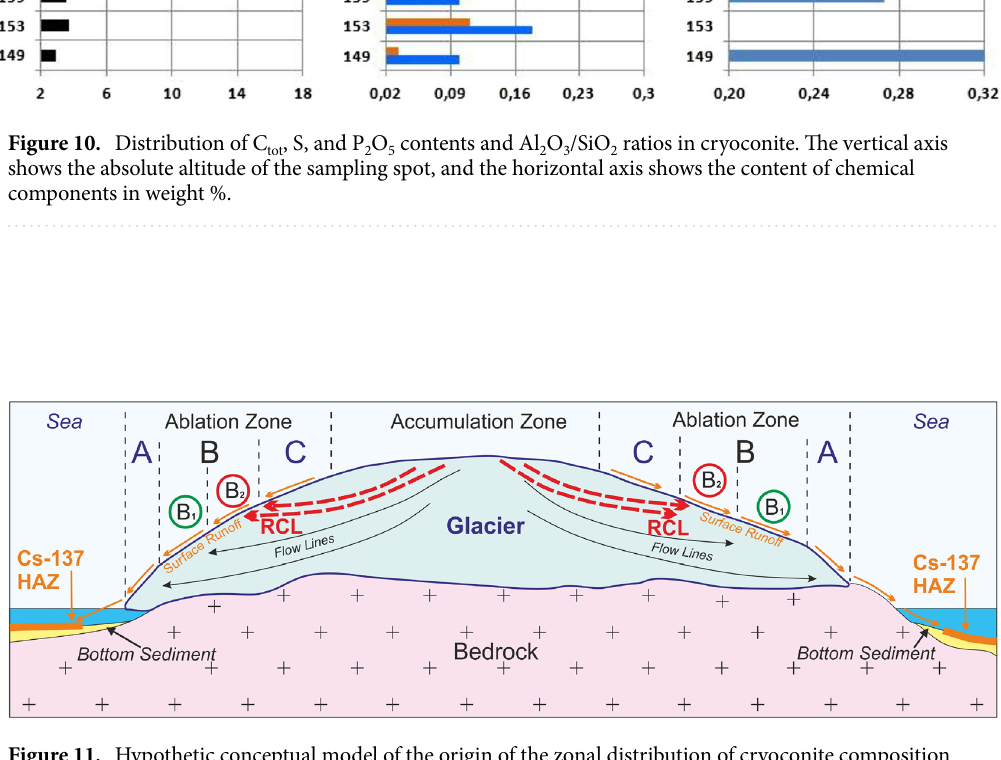
Figure 11. Hypothetic conceptual model of the origin of the zonal distribution of cryoconite composition on the surface of the Novaya Zemlya ice cap. RCL—radioactivity-contaminated layer; A—lower part of the ablation zone in which 137 Cs activity in cryoconite is below the global fallout level of 58–440 Bq kg −1 ; B—middle part of the ablation zone comprising the following zones: B 1 —zone with 137 Cs activity at the global fallout level HAZ—high activity zones of radiocesium in bottom sediments. This figure was created using Corel Draw X7 software (https:// www. corel draw.